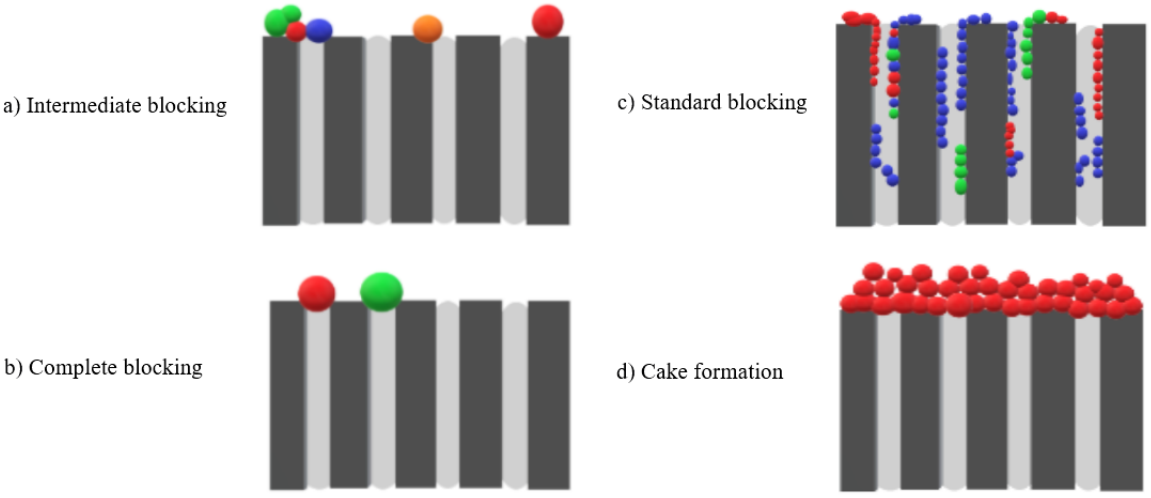
Figure 1. Fouling mechanisms ( a ) Intermediate blocking, ( b ) Complete blocking, ( c ) Standard blocking, ( d ) Cake formation.